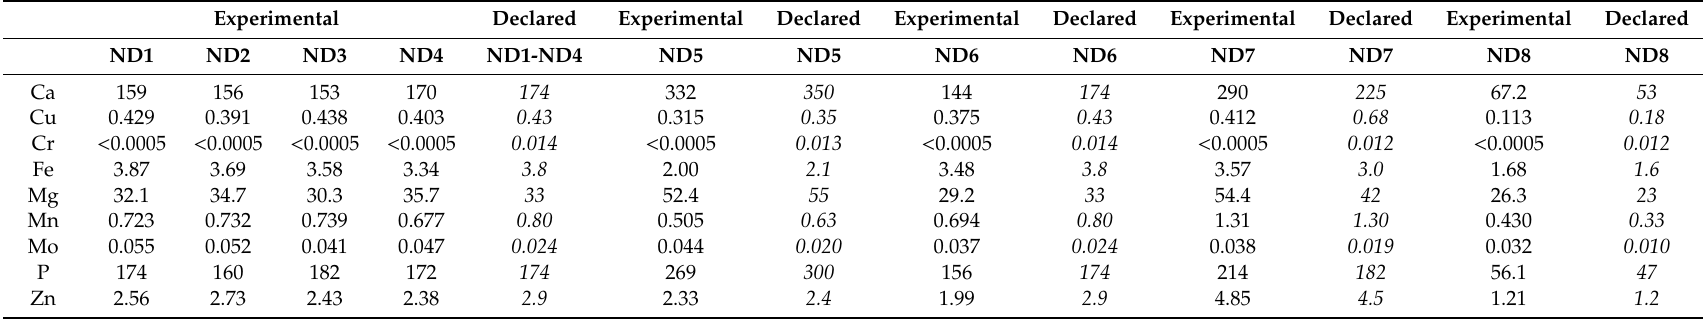
Table 3. Declared and determined concentrations of Ca, Cu, Cr, Fe, Mg, Mn, Mo, P and Zn (in mg L − 1 ) in nutritional drinks (NDs). Experimental Declared Experimental Declared Experimental Experimental